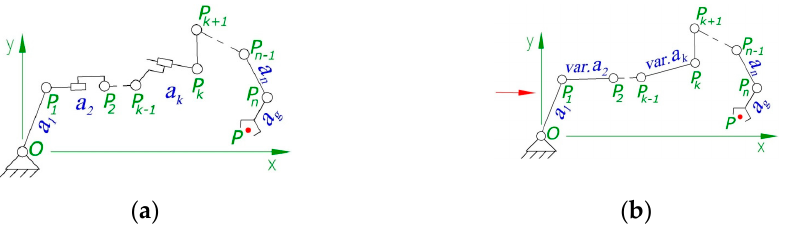
Figure 2. ( a ) Scheme of a planar serial robot with n rotational and translational degrees of freedom—and ( b ) its analogous representation with only rotational joints.